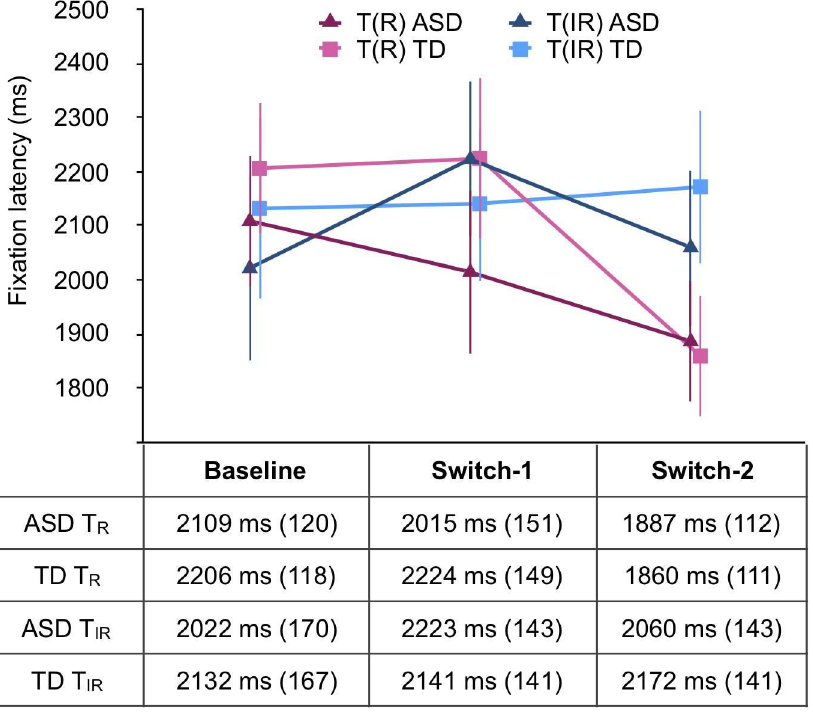
Fig 4. Average fixation latency for the T R and the T IR . Bars are 1 standard error of the mean. Mean and SE values are reported below.